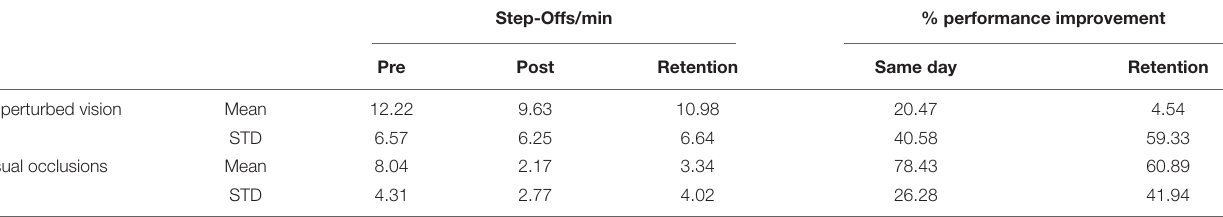
Step-Offs/min % performance improvement Pre Post Retention Same day